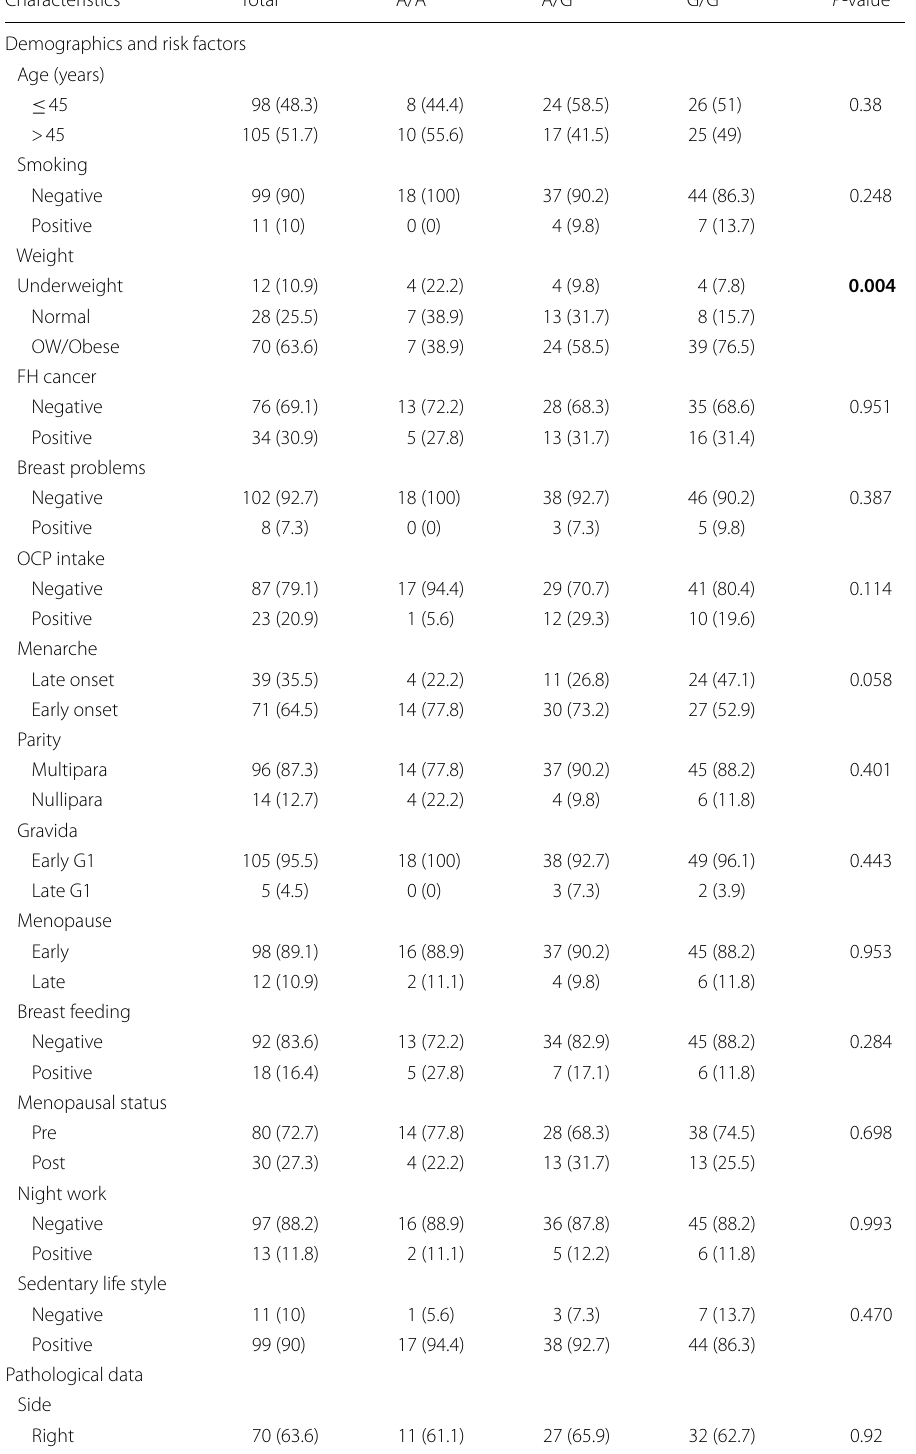
Table 2 Association between clinicopathological characteristics of breast cancer patients and CDKN2B-AS1 genotypes